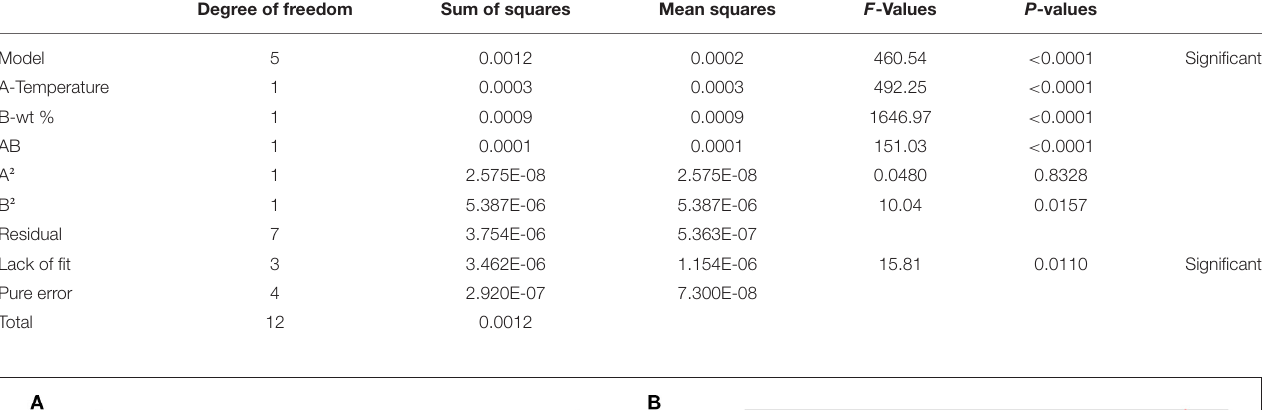
TABLE 3 | ANOVA results for the thermal conductivity of the nanofluid. Degree of freedom Sum of squares Mean squares F -Values P -values